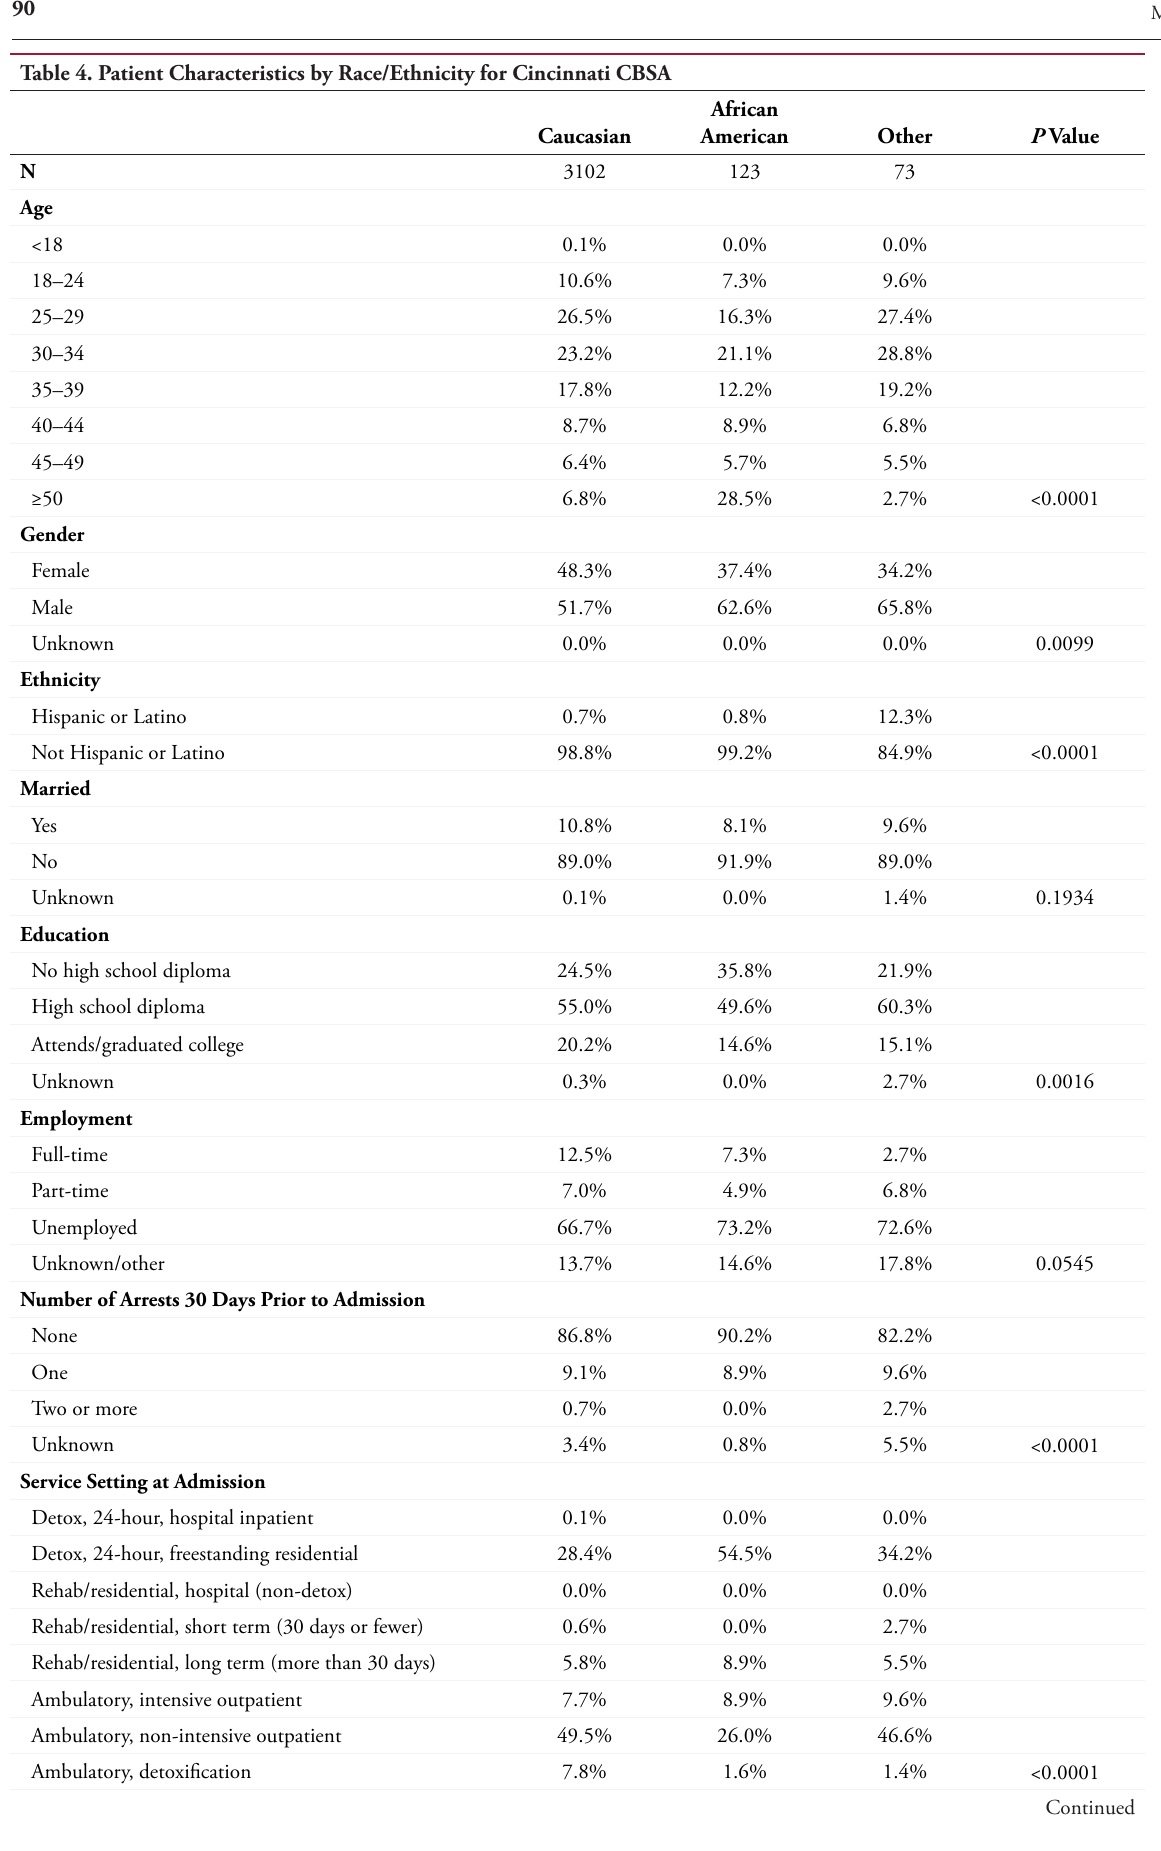
Table 4. Patient Characteristics by Race/Ethnicity for Cincinnati CBSA